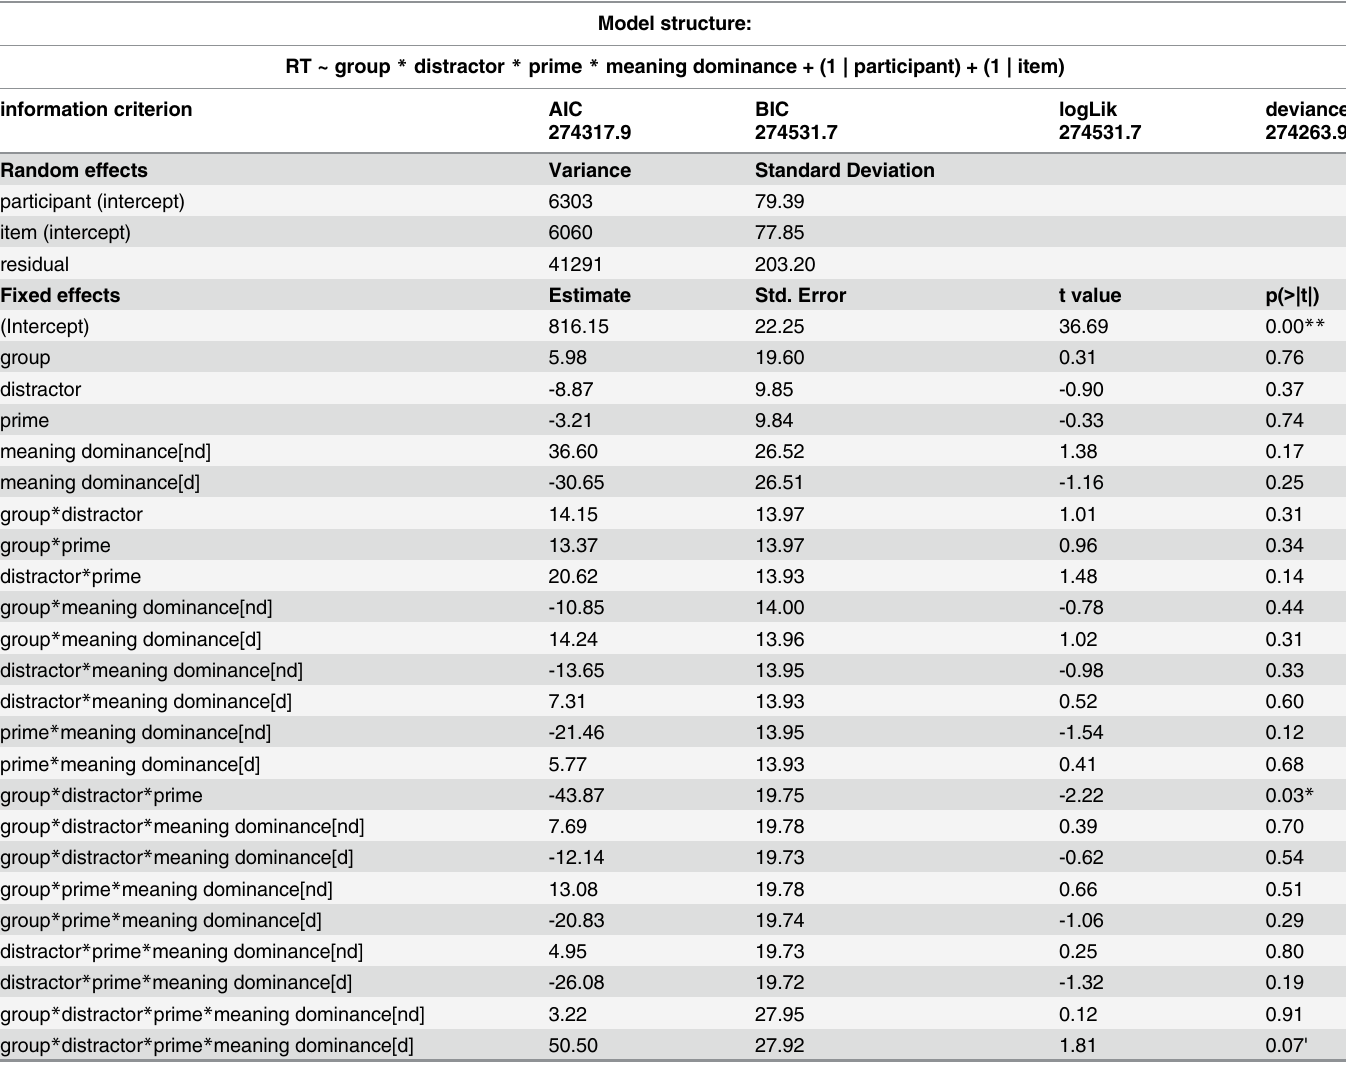
Table 2. Model summary and effect estimations of the overall LMM with crossed random effects for subjects and items including the factors prime relatedness, distractor relatedness, target meaning dominance and group. Model